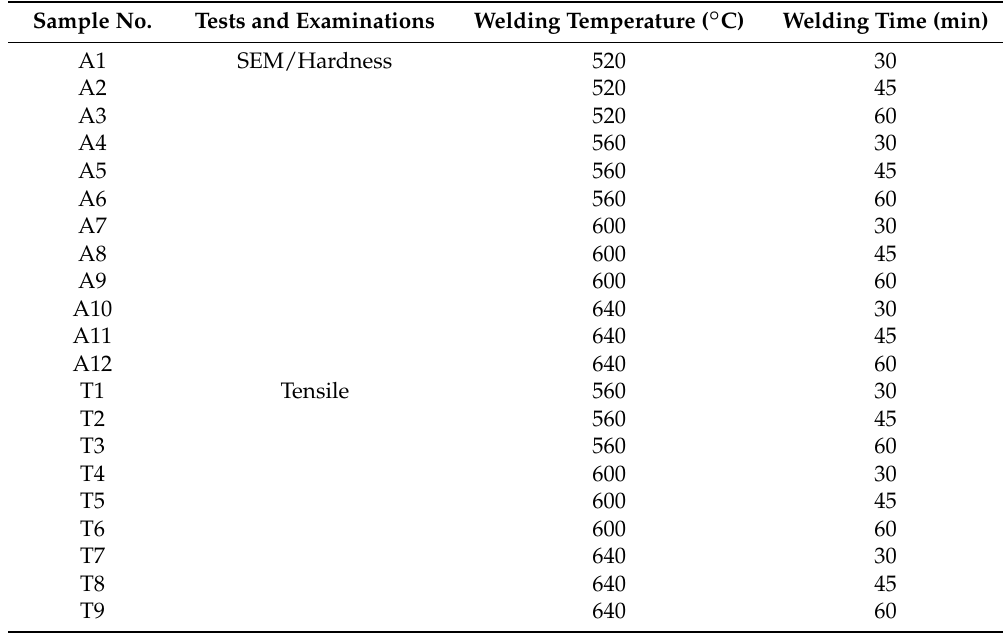
Table 3. Diffusion welding parameters.